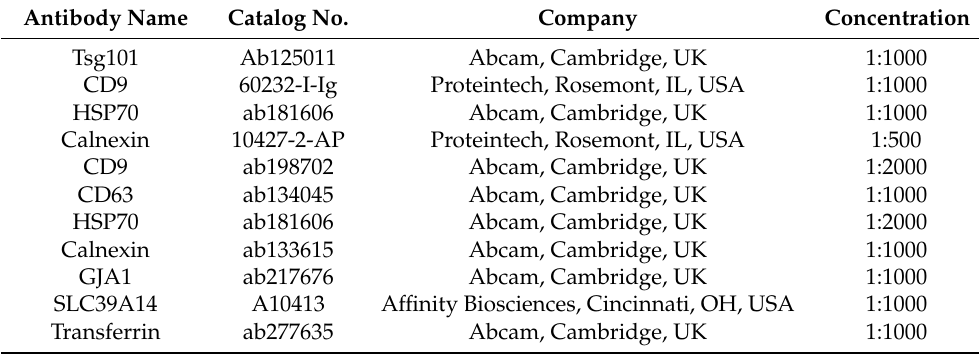
Table 1. Information of the antibodies used in this